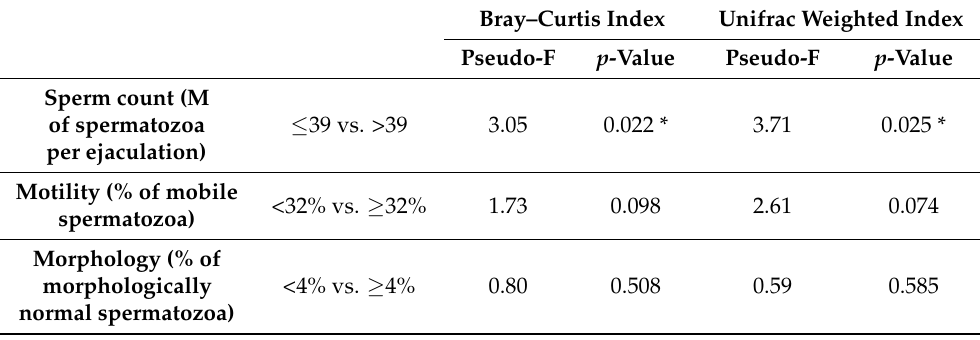
Table 2. Comparison of beta diversities, determined with different estimated indices (Bray–Curtis and weighted UniFrac indices) according to sperm parameters (* p < 0.05).